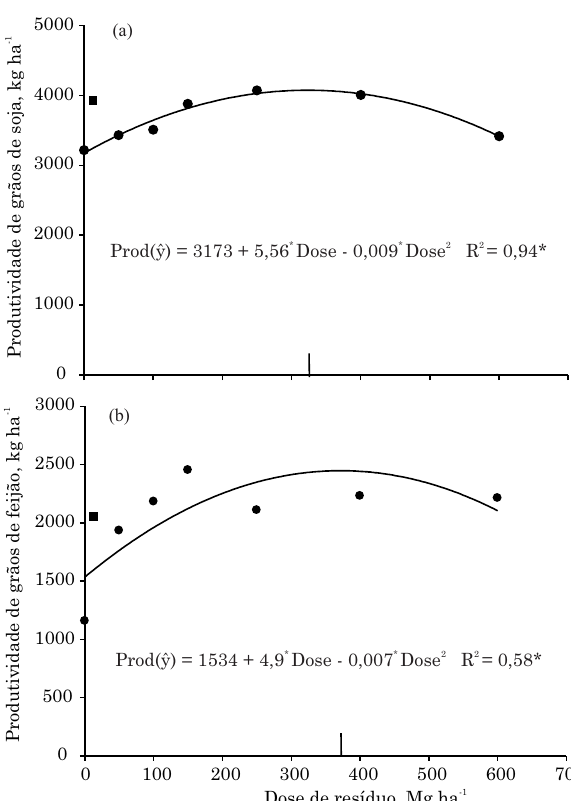
Figura 3. Produtividade de grãos de soja (a) e feijão (b) em função de doses de resíduo de reciclagem de papel ( lllll ) e com aplicação de calcário ( nnnnn ). * Significativo a 5 % pelo teste t. (|) máxima eficiência